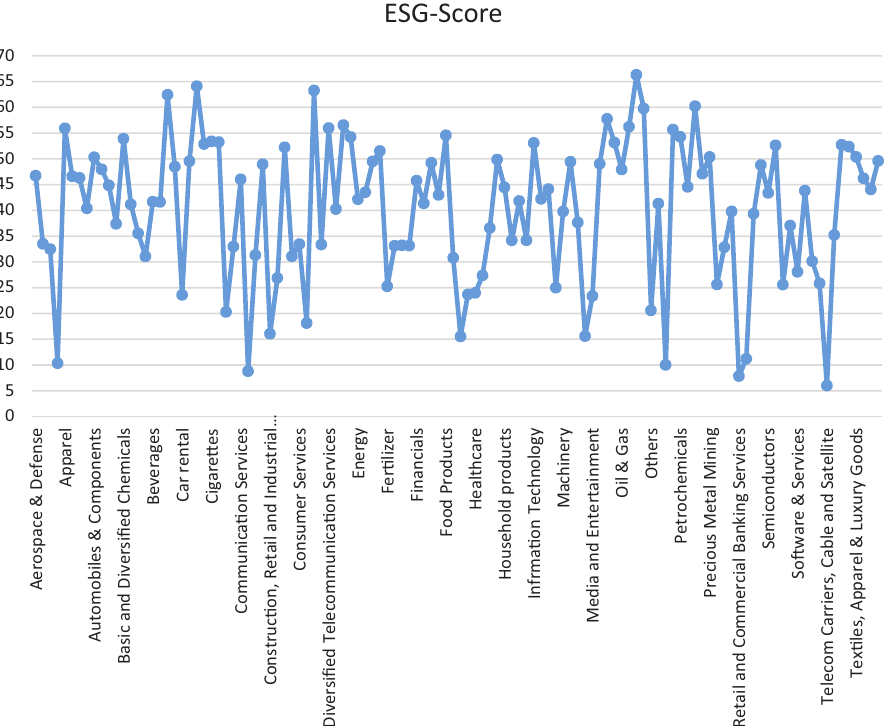
Figure 2. Industry-wise ESG score (source: author’s calculation)